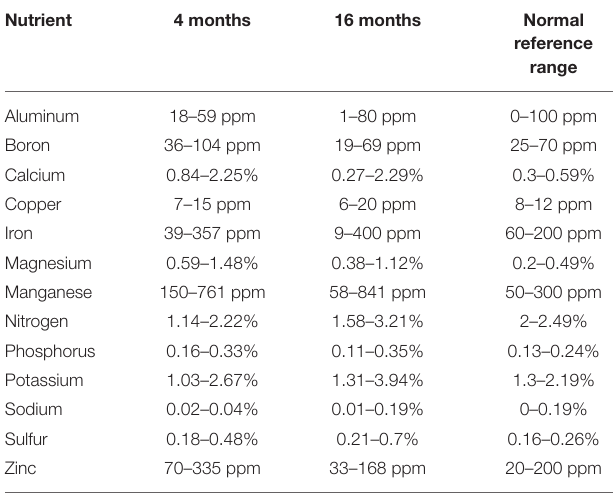
TABLE 2 | Ranges of leaf nutrient values in grafted T. cacao